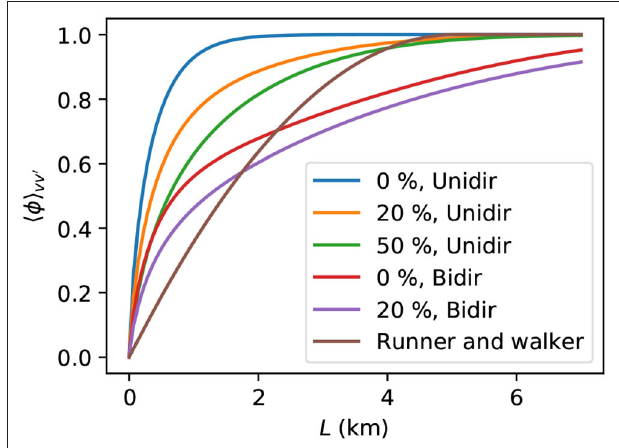
FIGURE 3 | Coefficient of diversity of the encounters, defined by Equation (12), with the fraction of runners and the direction indicated in the legend. The curve for one runner and one walker, with velocities respectively equal to 2.8 and 1.4 m/s in the same direction, uses Equation (11).